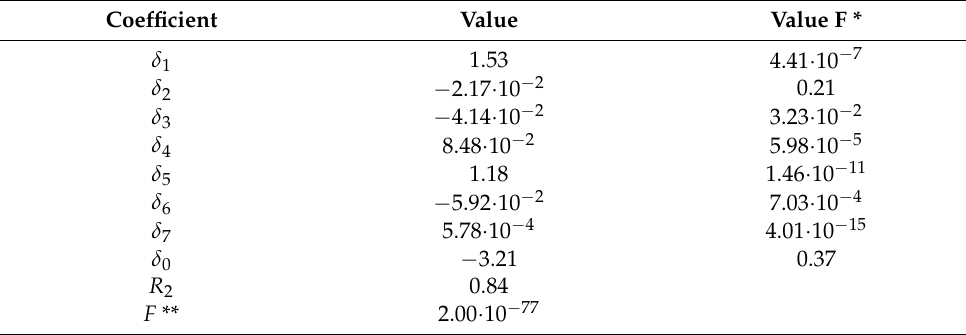
Table 3. Summary of statistical test results for the disc brake friction pad wear model.